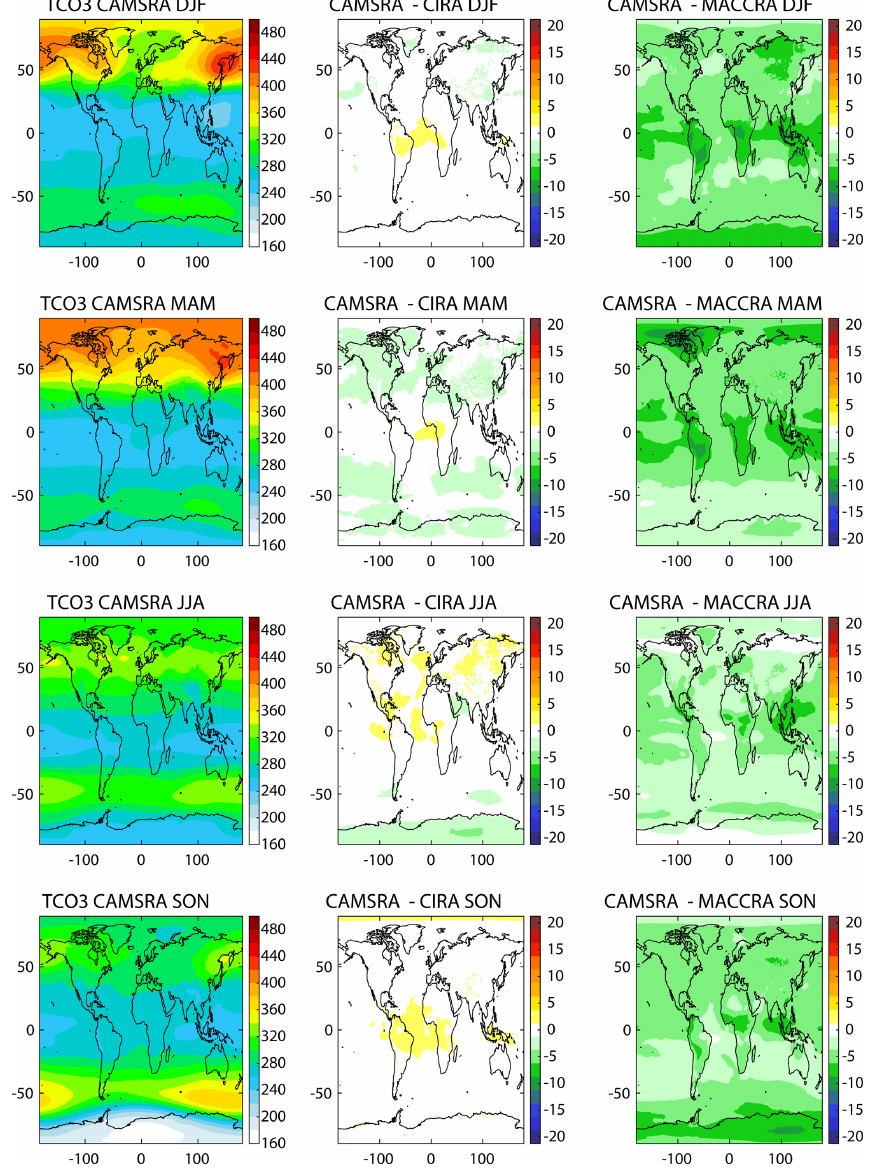
Figure 7. Seasonally averaged TCO3 from CAMSRA (2003–2016, left), difference between CAMSRA and CIRA (middle), and difference between CAMSRA and MACCRA (right, 2003–2012 only) in DU for the seasons DJF (row 1), MAM (row 2), JJA (row 3) and SON (row